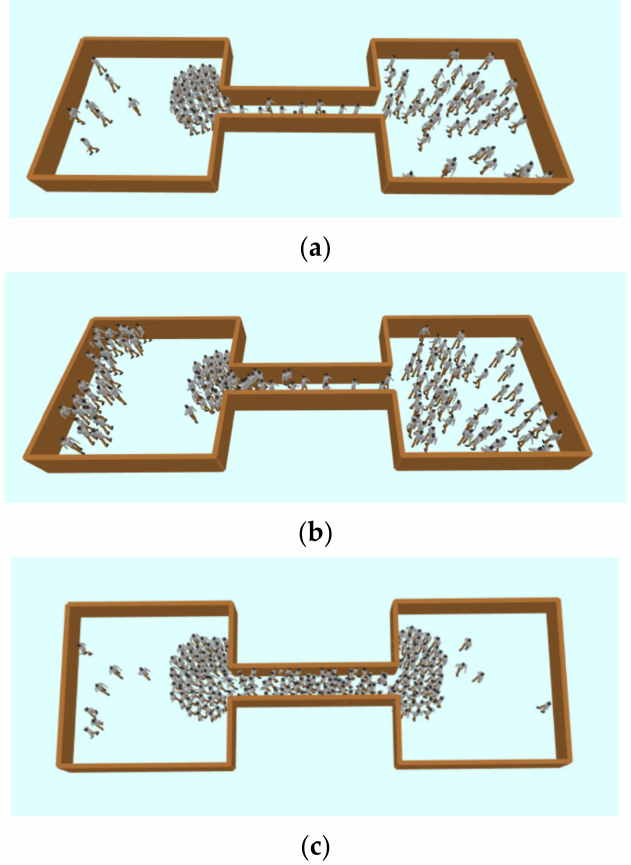
Figure A7. The scenario of test 7. ( a ) Time = 111 s; ( b ) time = 157 s; ( c ) time = 183